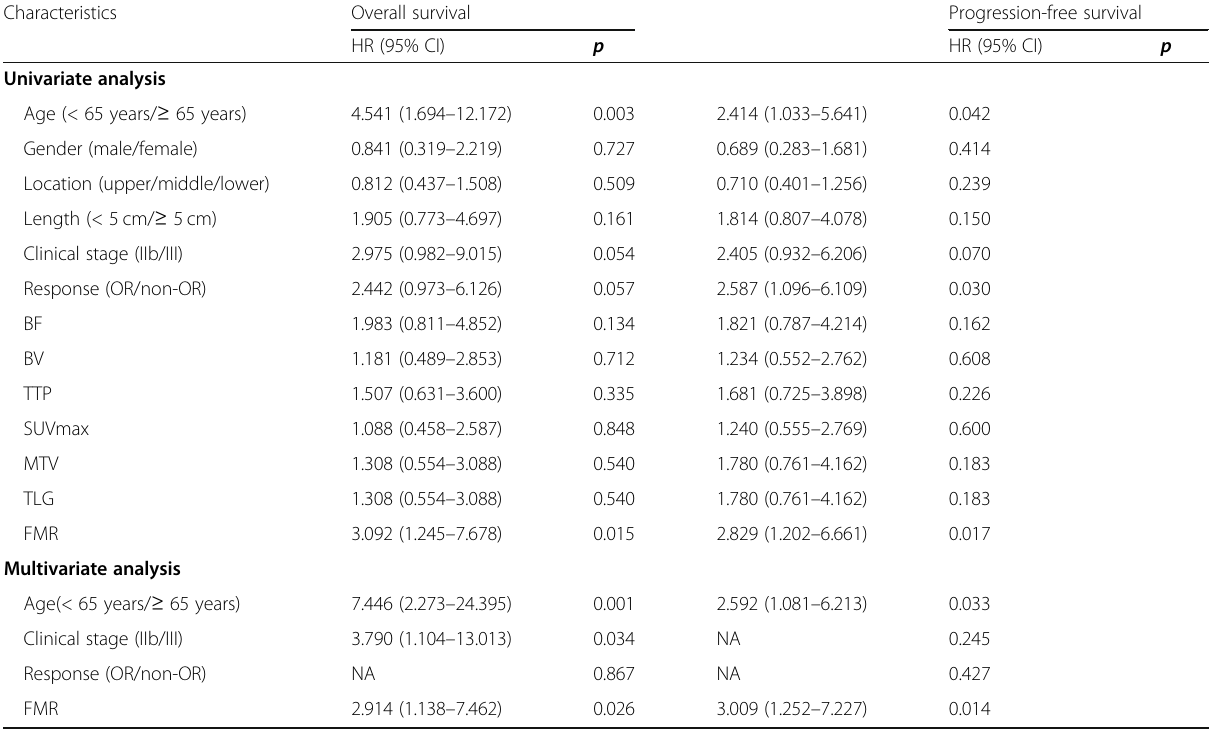
Table 4 Univariate and multivariate analysis of factors associated with overall survival and progression-free survival Characteristics Overall survival Univariate